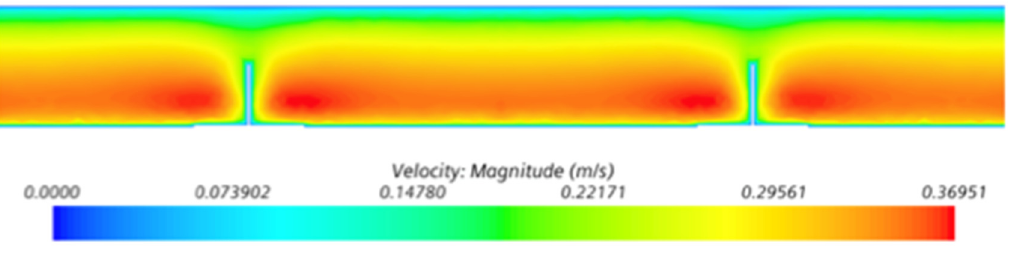
Figure 13. Velocity field—horizontal cross section at height of 10 m summer extreme.